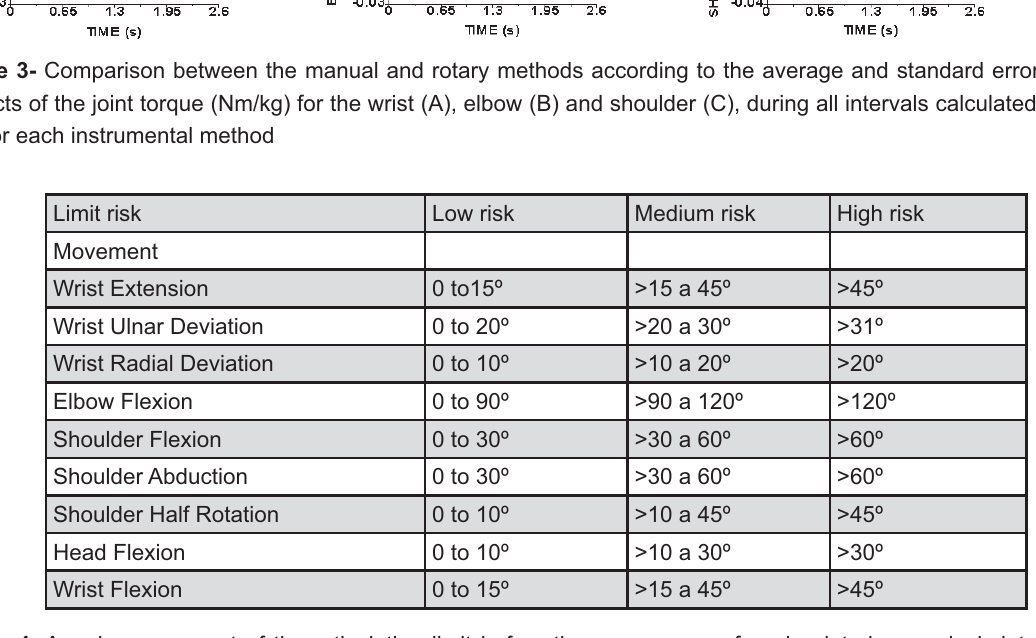
Figure 4- Angular movement of the articulation limit before the appearance of work-related musculoskeletal disorders (cid:27)’*;"(cid:29)(cid:8)(cid:26)(cid:4)(cid:3)(cid:7)(cid:7)(cid:13)<(cid:6)(cid:12)(cid:8)(cid:3)(cid:7)(cid:8)(cid:4)(cid:17)(cid:25)(cid:30)(cid:8)%(cid:6)(cid:12)(cid:13)(cid:5)%(cid:8)(cid:17)(cid:11)(cid:8)(cid:20)(cid:13)(cid:15)(cid:20)(cid:8)(cid:11)(cid:13)(cid:7)=(cid:7)(cid:8)(cid:24)?(cid:8)(cid:31)(cid:11)(cid:3)%(cid:7)(cid:17)(cid:14) 4 (1998)